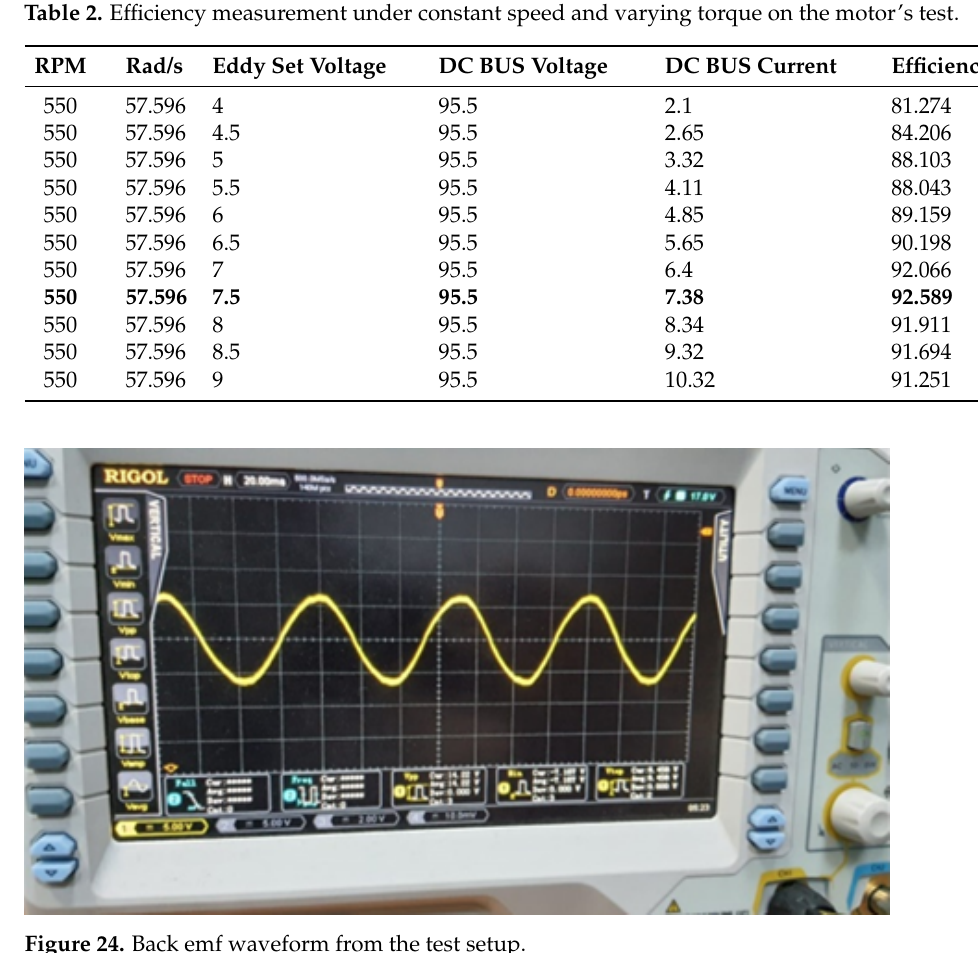
Figure 24. Back emf waveform from the test